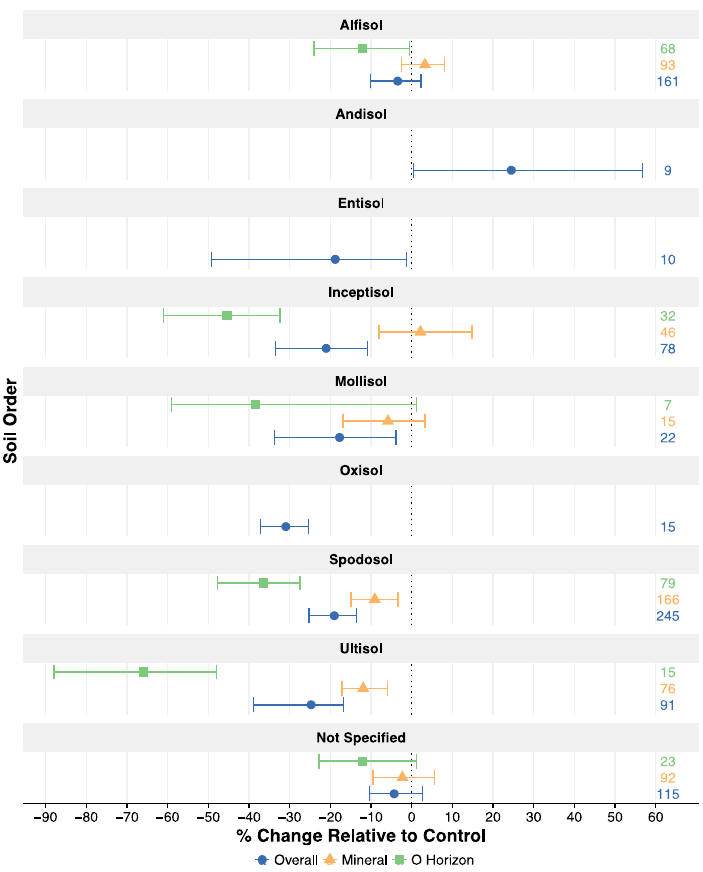
Figure 2. Response of soil C to harvesting in different soil orders. Mean effect sizes ± 95% confidence intervals calculated by nonparametric bootstrap are shown for all response ratios in each soil order (Overall) and broken out into mineral soil or O horizon. The number of response ratios ( k ) comprising each mean effect are listed on the right. Effect sizes were calculated only on response ratios reported in pool units ( k = 746).